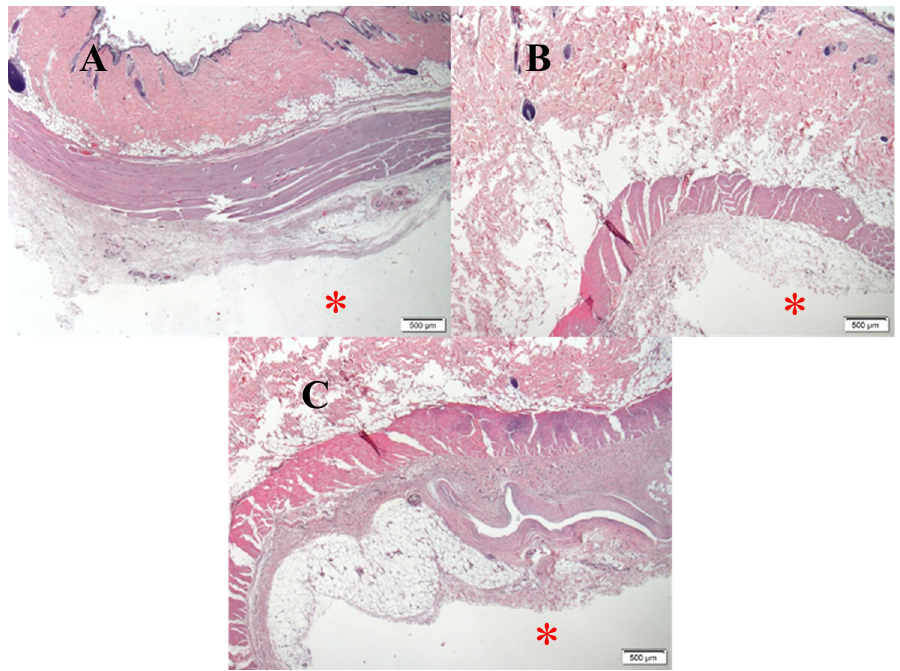
Figure 16. Histological analysis of subcutaneous tissue in the vicinity of the implants. ( A ) Pure Zn; ( B ) Zn–1.3Fe; ( C ) Ti–6Al–4V. * marks the implants location.